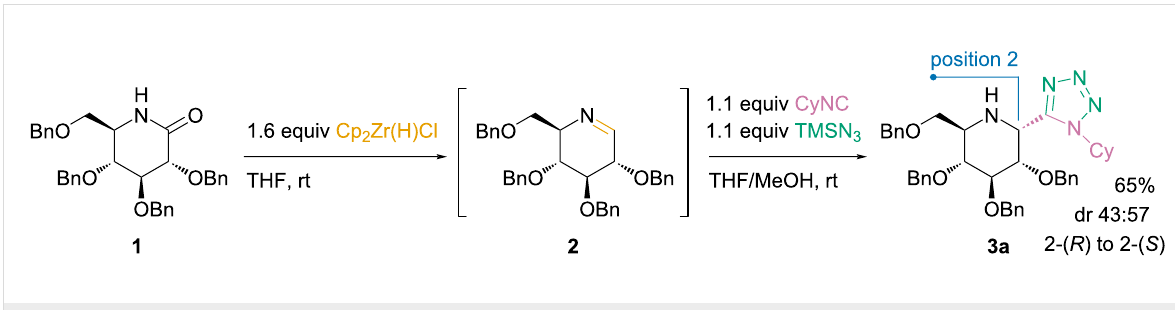
Scheme 2: Preliminary experiment in search of a procedure for the synthesis of 2-(1 H -tetrazol-5-yl)-iminosugars.